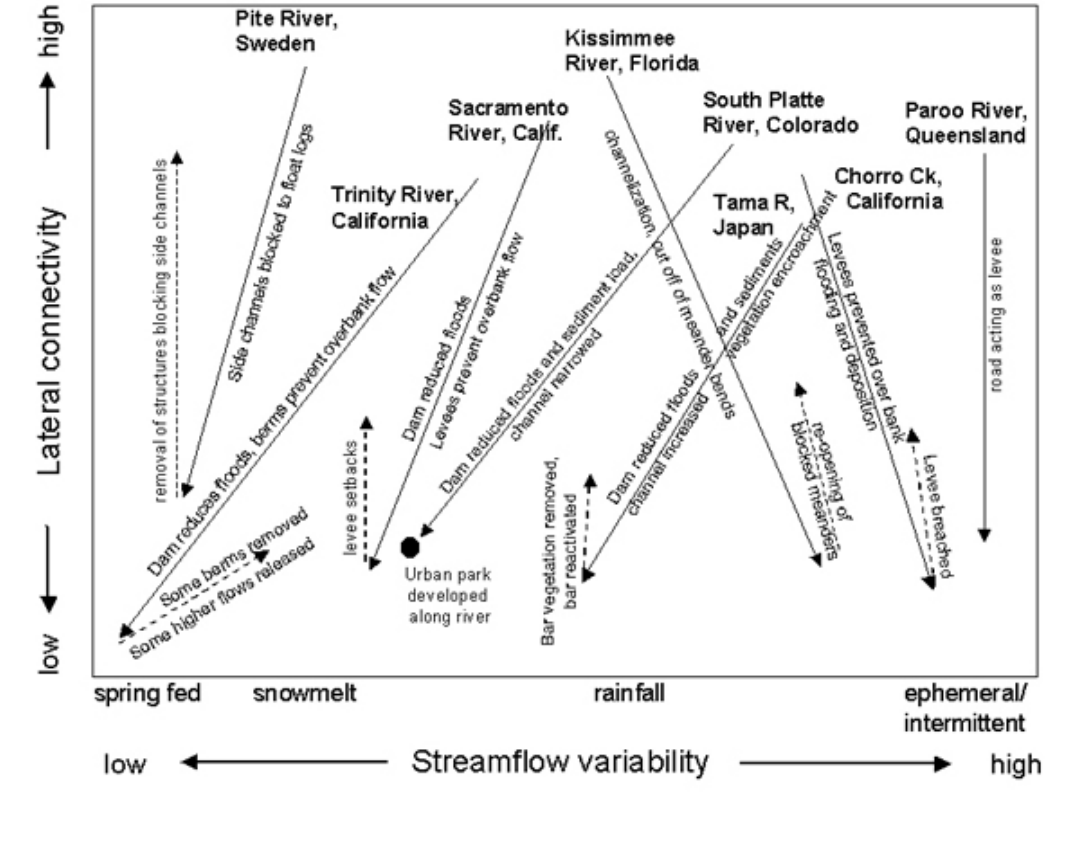
Fig. 2. Solid arrows represent ecological degradation and dashed arrows represent restoration trajectories plotted on axes of lateral connectivity and flow dynamics. See Appendix 1 for a discussion of